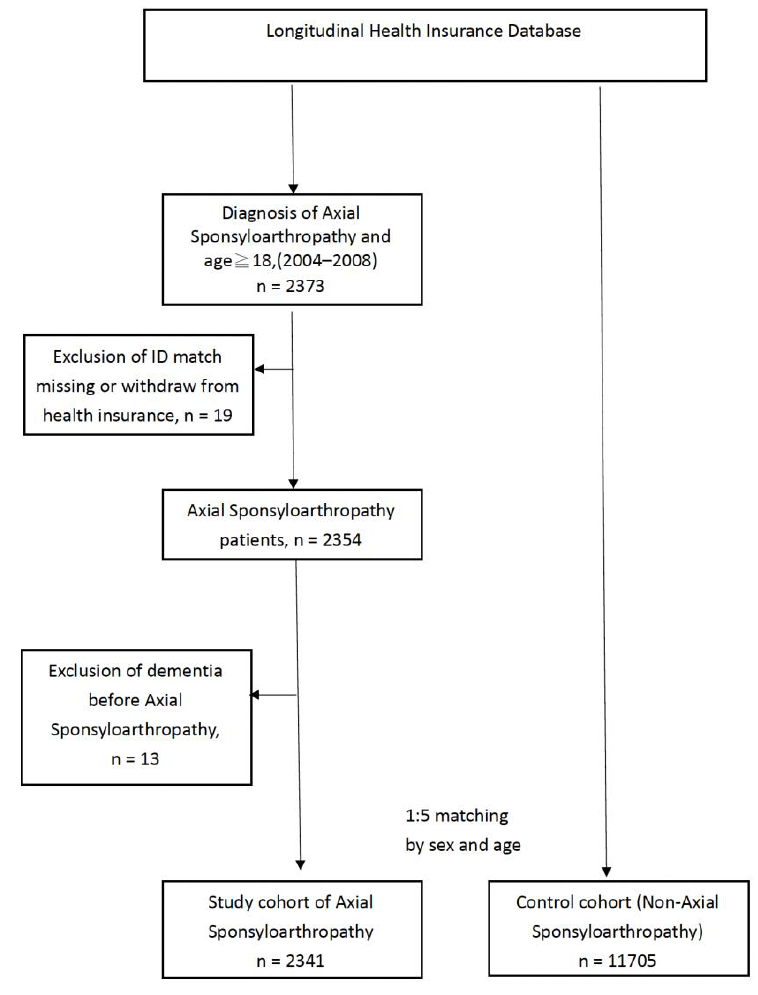
Figure 1. Study flow chart.